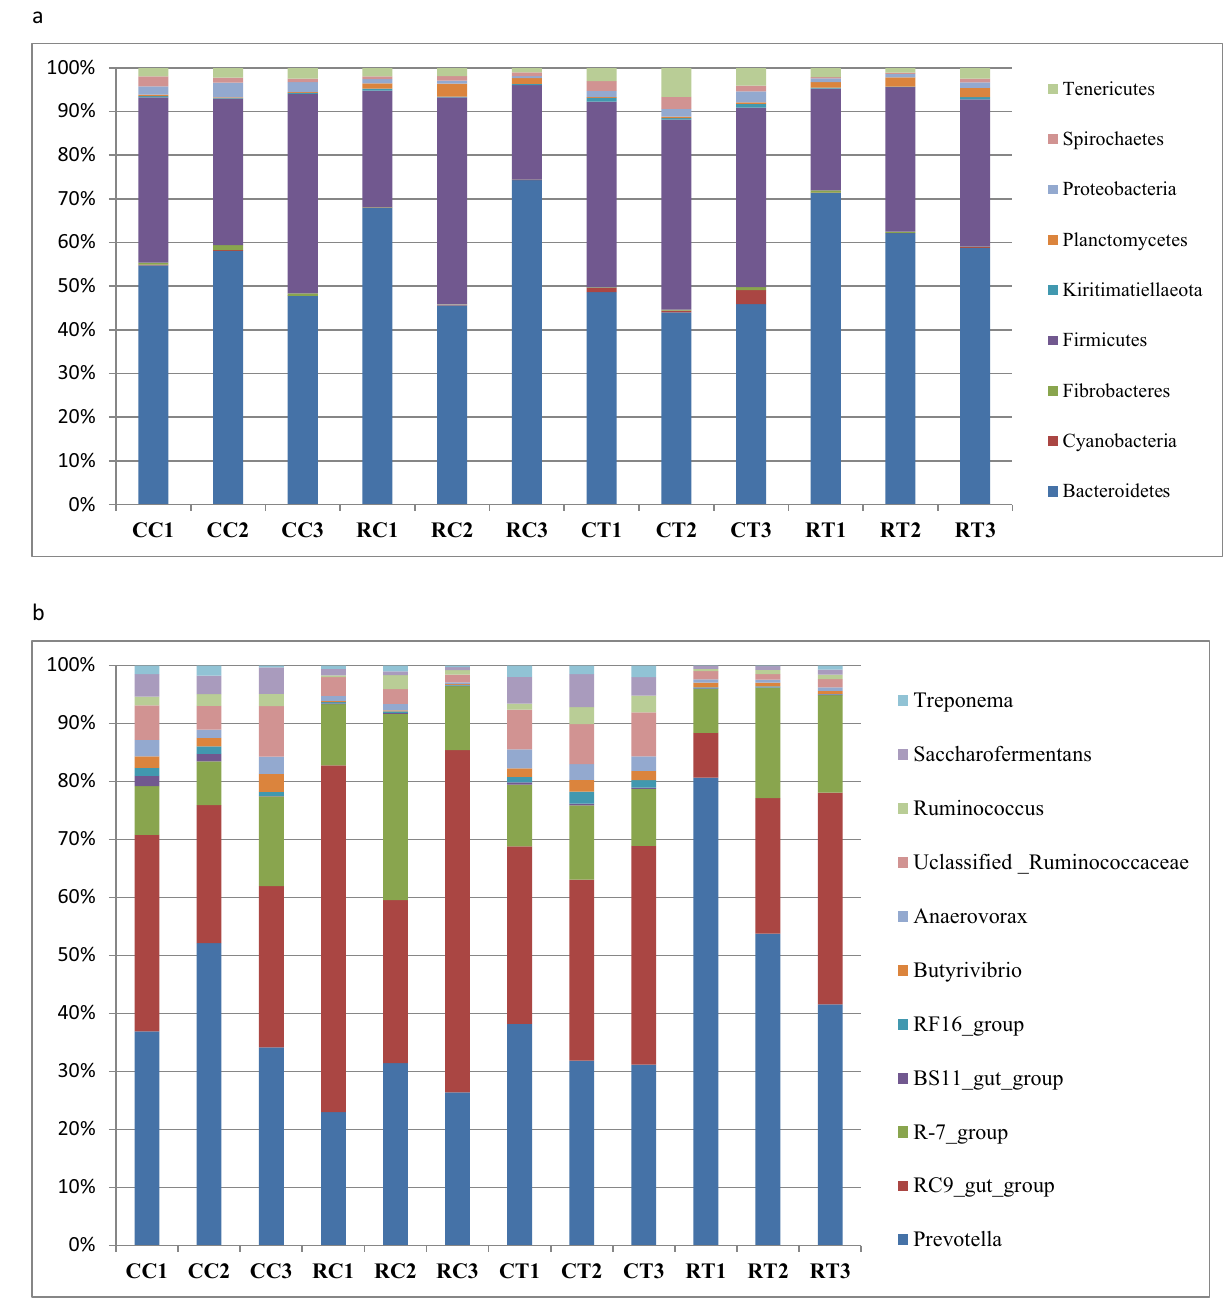
Figure 2. Relative abundance of bacterial families and genera. The relative abundances of dominant bacterial phyla ( a ) and bacterial genera ( b ) in the rumen of non-supplemented camels (CC1–CC3), non-supplemented sheep (CR1–CR3), supplemented camels (TC1–TC3), and supplemented sheep